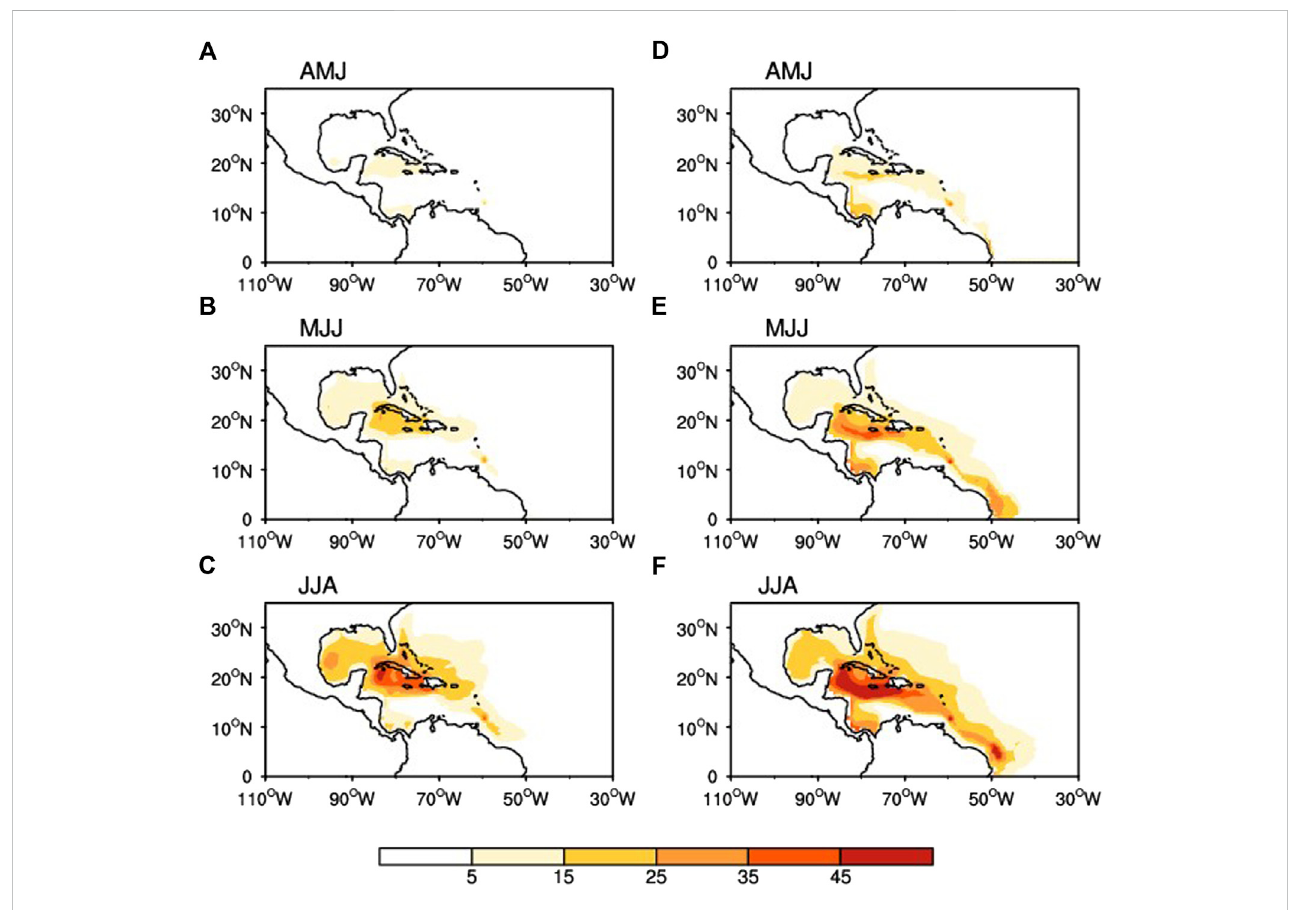
FIGURE 6 (A – C) Composite of following 3-month-averaged depth (m) of the 28.5 ° C isotherm from positive NAD cases; (D – F) as in (A – C) but from negative NAD